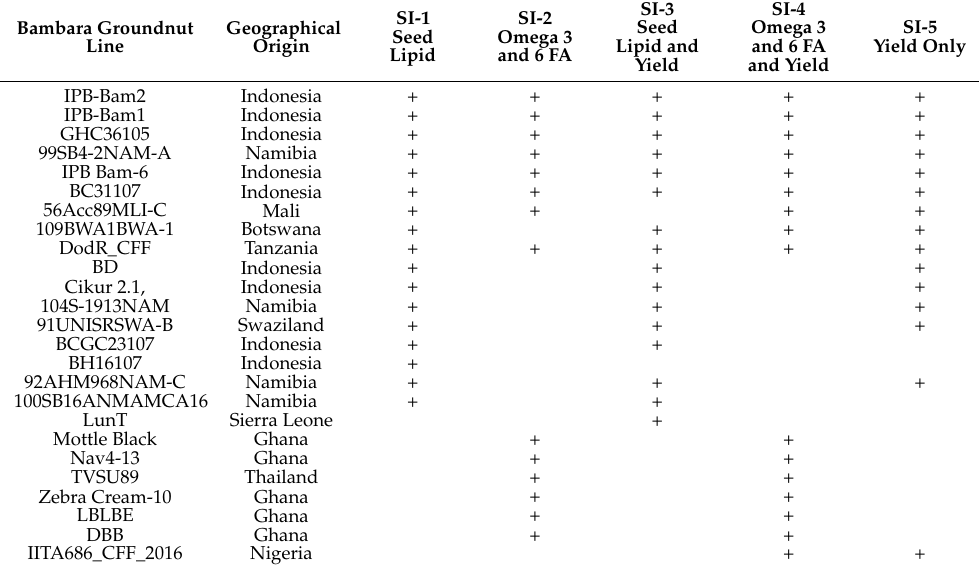
Table 7. Summary of bambara groundnut lines with positive scores for all scenarios tested in each of the indices (SI): seed lipid (SI-1), omega 3 and 6 fatty acids (SI-2), seed lipid and yield (SI-3), omega 3 and 6 fatty acids and yield (SI-4), and yield (SI-5). Positive scores are indicated with a plus sign (+). Bambara Groundnut Geographical Line Origin